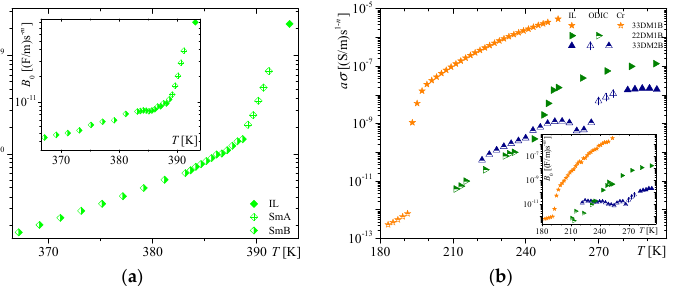
Figure 4. Dependence of the dielectric conductivity on temperature for ( a ) 6BBAA in the IL, SmA, SmB phases, and ( b ) three DMB isomers, i.e., 33DM1B (IL and Cr phases), 22DM1B (IL and ODIC phases), and 33DM2B (IL and ODIC phases). Inserts show temperature dependencies of B 0 .